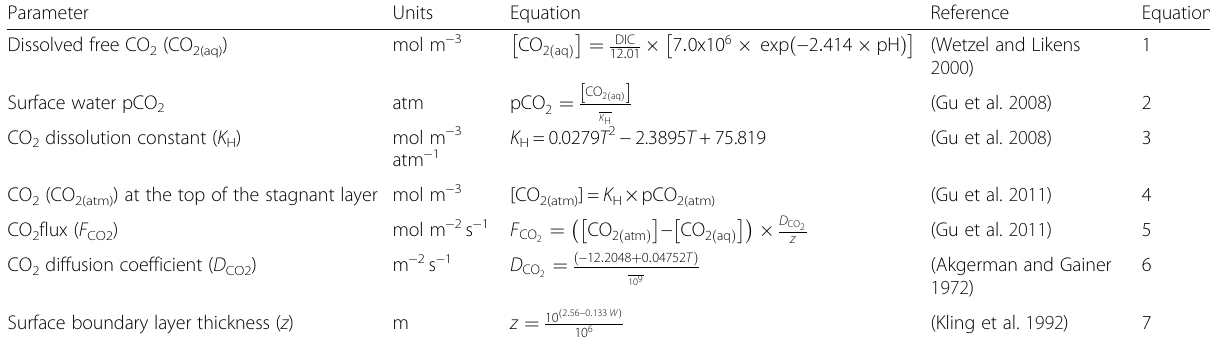
Table 1 Equations used to calculate surface water pCO 2 concentrations and CO 2 flux rates Parameter Units Equation Dissolved free CO 2 (CO 2(aq)